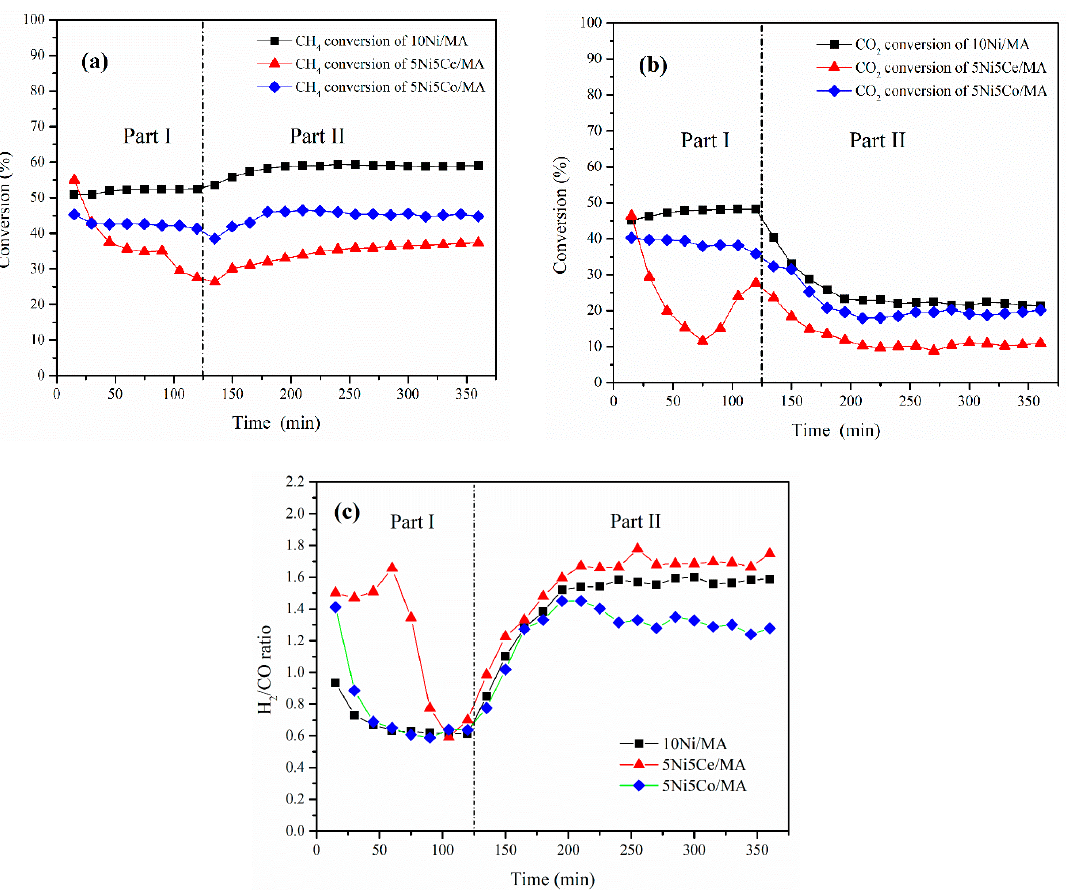
Figure 6. TheCH 4 ( a )andCO 2 conversions( b )forCSCRMandH 2 / COratios( c )of10Ni / MA,5Ni5Ce(T) / MA, Figure 6. The CH 4 ( a ) and CO 2 conversions ( b ) for CSCRM and H 2 /CO ratios ( c ) of 10Ni/MA, and 5Ni5Ce / MA catalysts at 620 ◦ C under ambient pressure (the relative error is about 5Ni5Ce(T)/MA, and 5Ni5Ce/MA catalysts at 620 °C under ambient pressure (the relative error is about 3%).